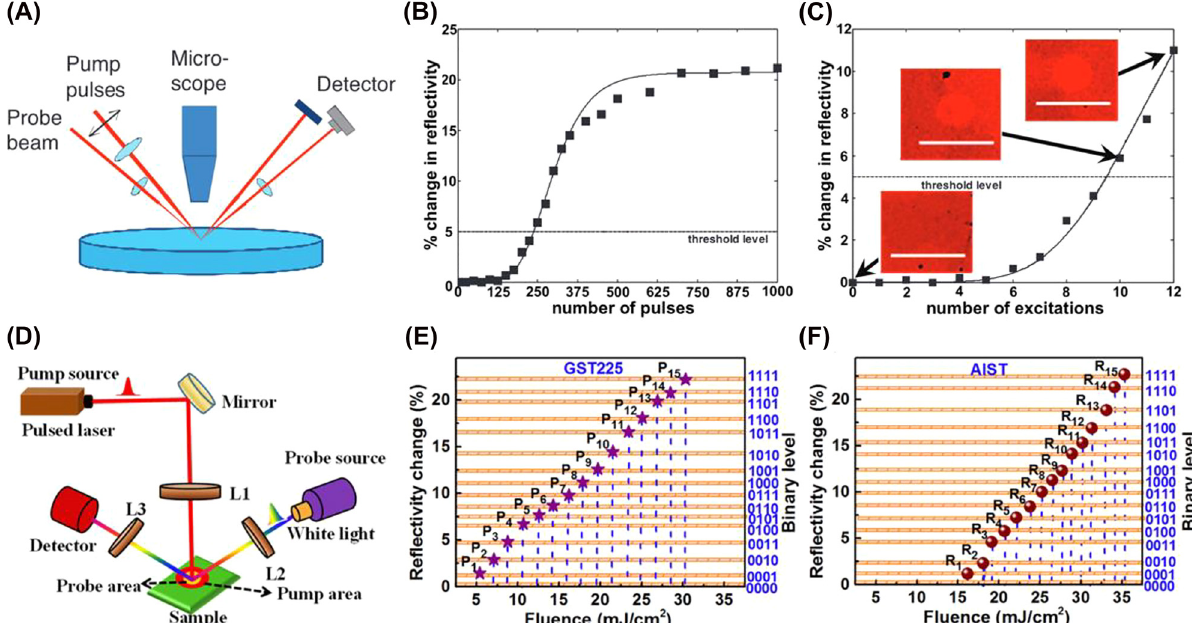
Figure 2: (A – C) Experimental demonstration of the natural accumulation property in PCMs [37]. (A) Schematic of the pump-probe setup for re fl ectivity measurement. (B) Percent change in GST re fl ectivity as a function of the number of 85 fs, 3.61 mJ/cm 2 pulses applied. (C)